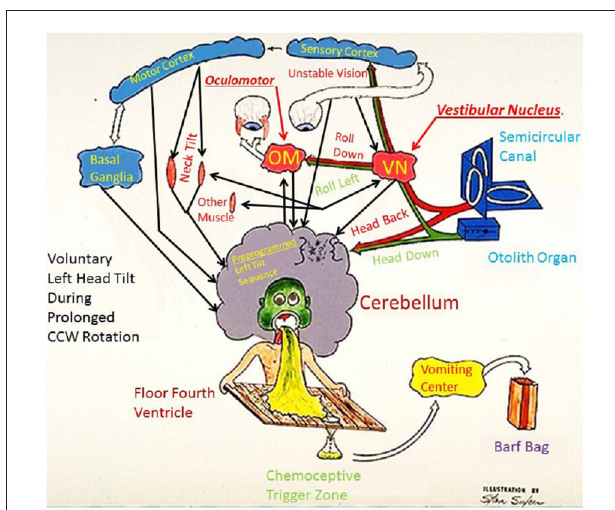
FIGURE 1 | Fred Guedry’s humorous model of the neural responses to a sensory rearrangement challenge. The rearrangement is caused by Coriolis cross-coupled head movements employed as part of the adaptation challenge in Study #1 (Explanation in body of